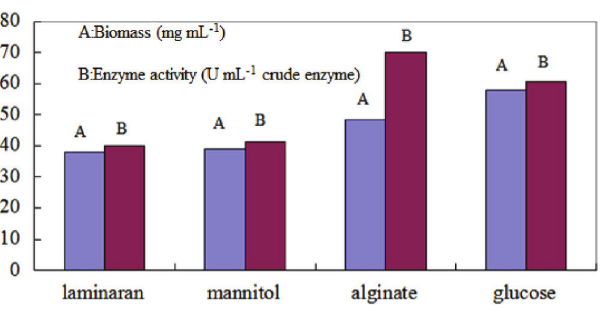
Fig. 1 – Enzyme fermentation with different carbon